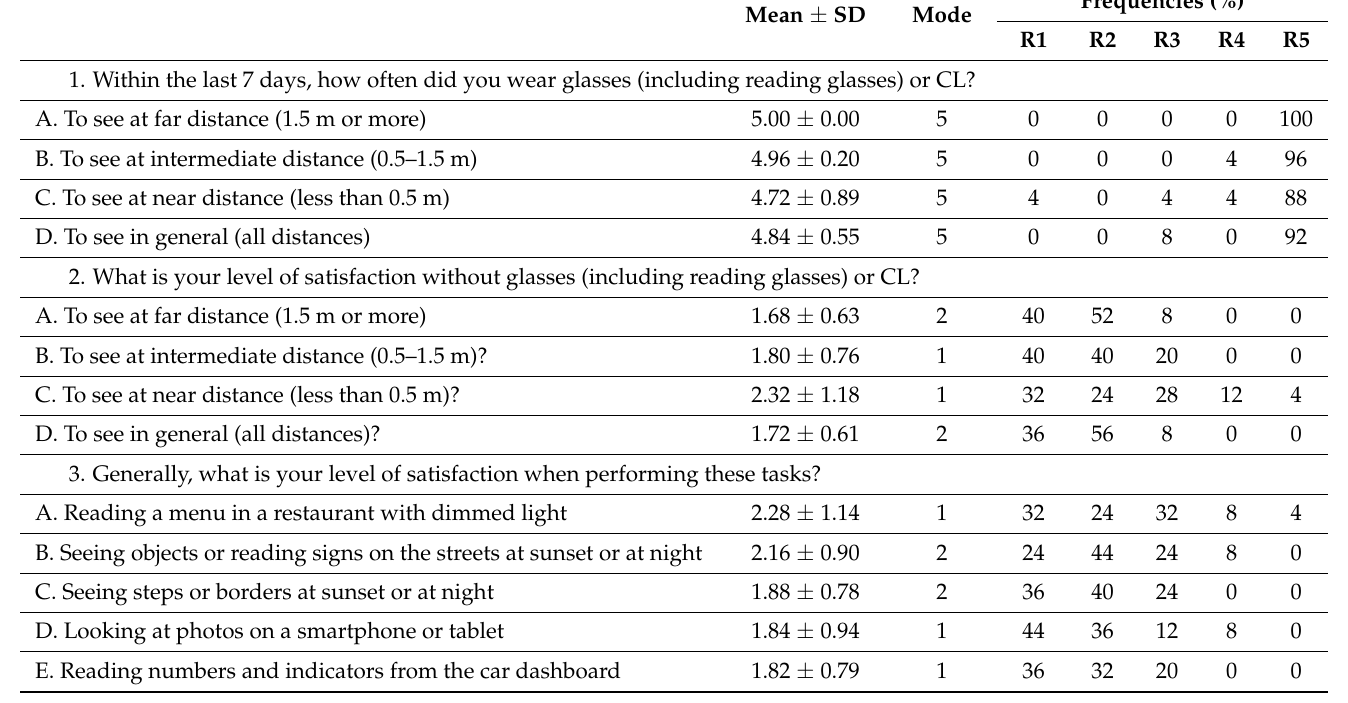
Table 3. Summary of 25 patients’ reported outcomes for spectacle independence as per the PRSIQ. Response coding for items 1A–1E/2A–3E: R1 (all the time/completely satisfied), R2 (most of the time/very satisfied), R3 (sometimes/fairly satisfied), R4 (rarely/little satisfied), R5 (never/unsatisfied). SD: standard